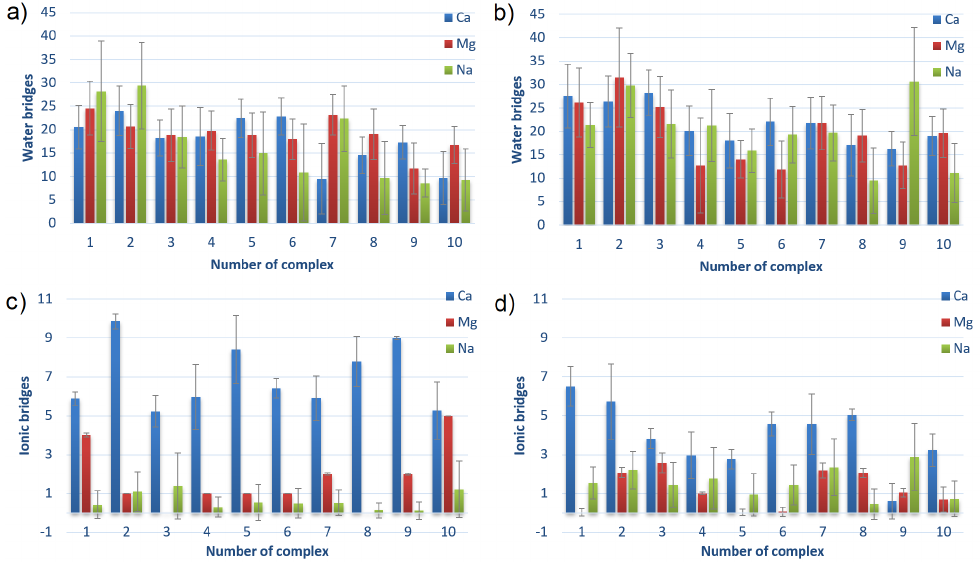
Figure 9. The number of hydrogen bonds mediated by water molecules (water bridges) and the number of ionic interactions mediated by cations (ionic bridges) between HSA and CS-6 ( a , c ) and between HSA and CS-4 ( b , d ). The complexes are sorted from lowest to highest averaged energy of binding after MD simulations; thus, the first is the strongest bound (cf., Table 1). Error bars present doubled